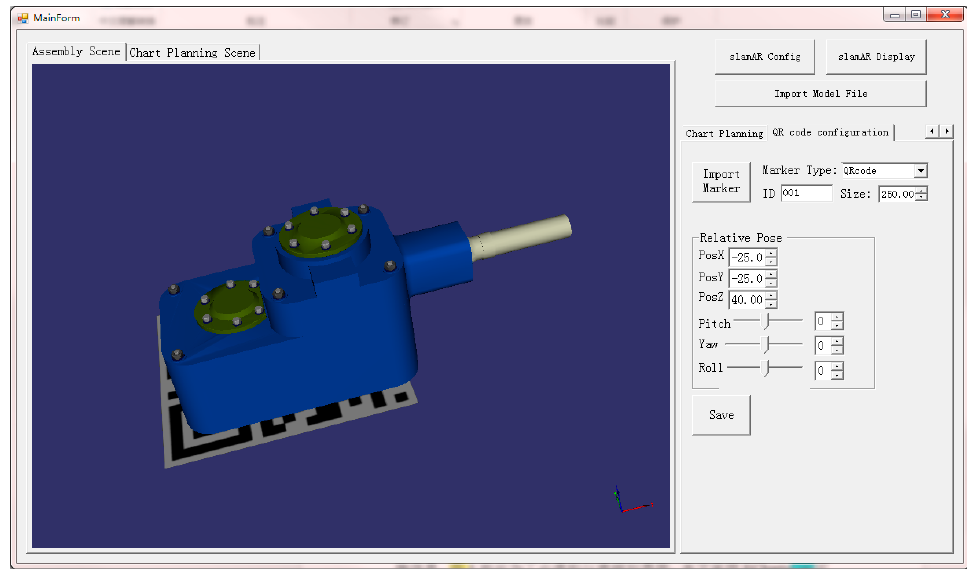
Figure 4. QR code information configuration interface.